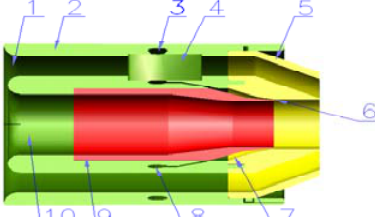
Fig 1. Cross section of aerial injector: 1) external air duct, 2) the main module, 3) the first ring inside external wall to feed of fuel, 4) one of three fairing to feet fuel, 5) module of external swirled, 6) the duct of fuel stream outlet, 7) the feed duct of fuel to outlet, 8) second ring inside internal wall to feed the fuel, 9) module of internal swirled, 10) internal air duct